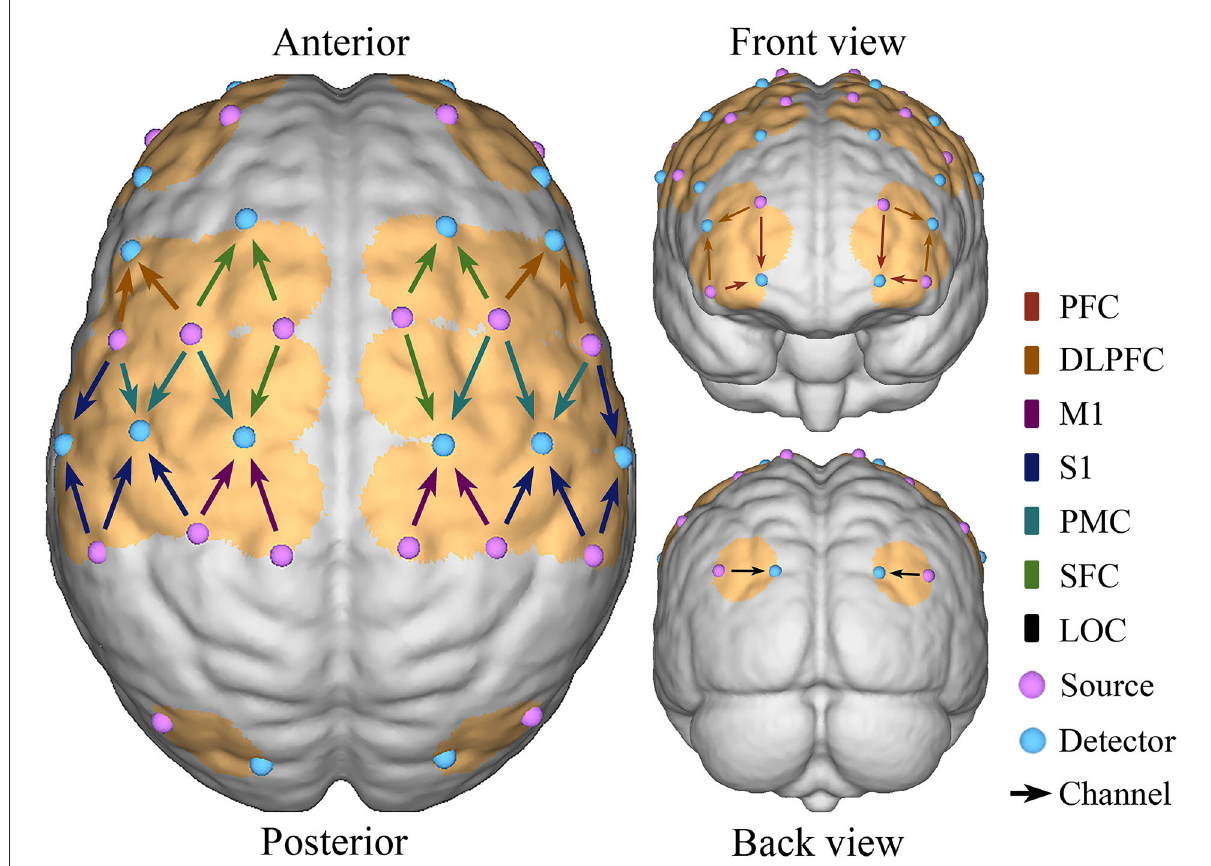
FIGURE2 Schematic diagram of the fNIRS. Configuration of 18 source probes, 16 detector probes, and 38 measurement